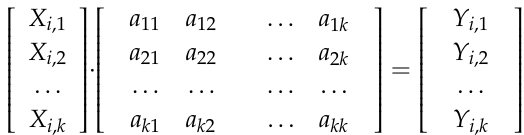
Figure 3. Spatial patterns of change trends calculated by MK ( a ) and MMK ( b ). 3.2. Frequencies of Wet/Dry Events Based on the classification of different types of wet/dry events, as defined in Table 1, the frequencies of these events were spatially mapped for the YRD (Figure 4). The stations with high frequencies of extremely wet events are located in a dispersed way, including the northwestern,